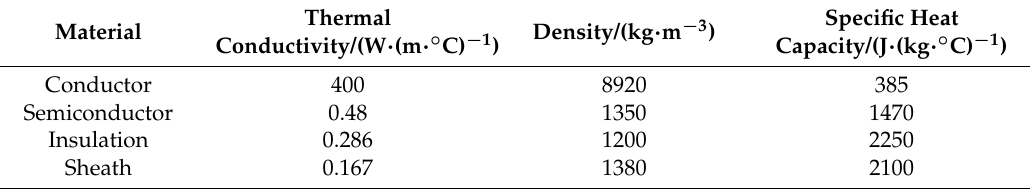
Table 3. Material physical parameters used for temperature field calculation.